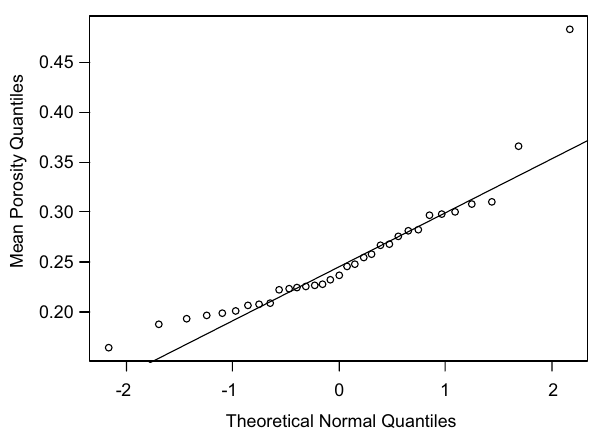
Fig. 7 Normal Quantile–Quantile plot of well-mean porosity val- ues—field-wide